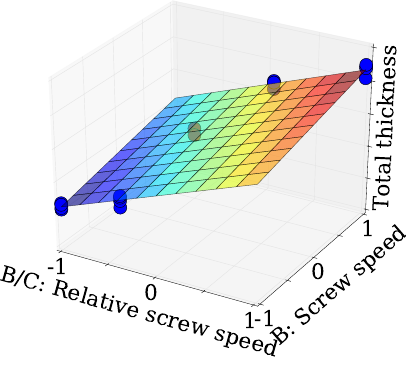
Figure 5: Electric current contrasts